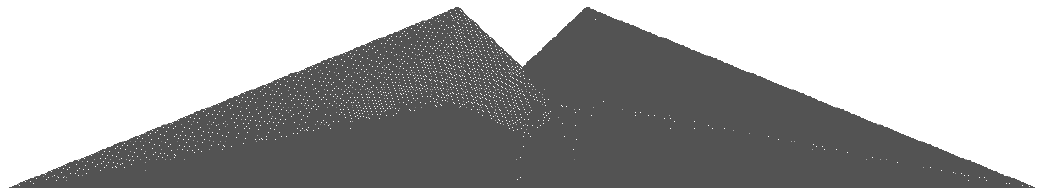
Fig. 3. Computational mesh for the 25 o pitch enclosure .